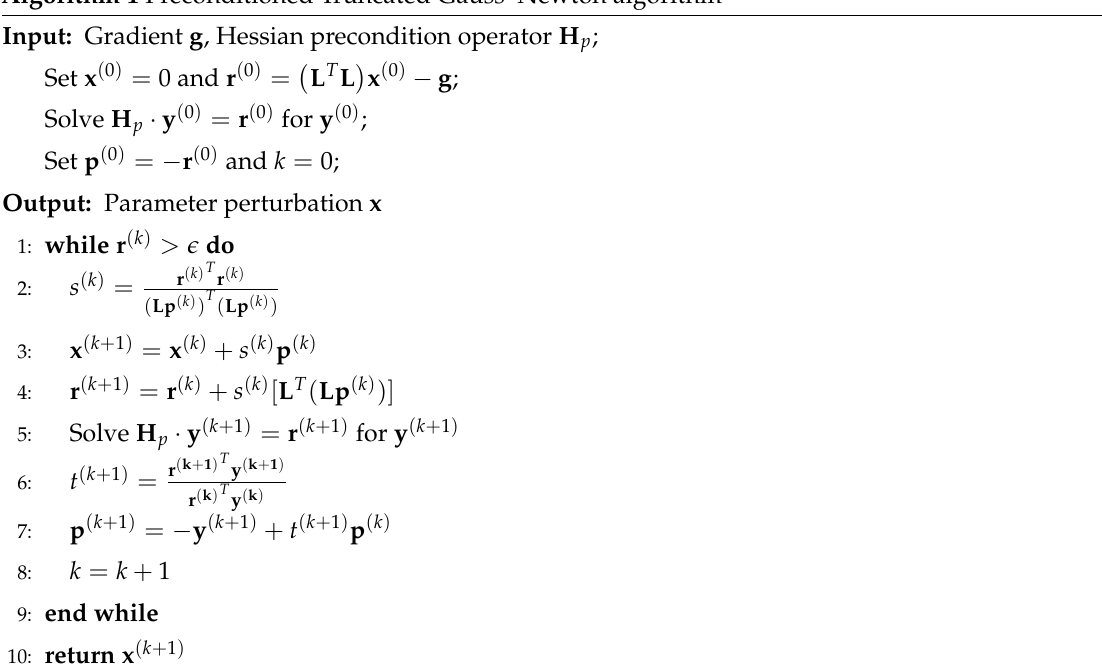
Algorithm 1 Preconditioned Truncated Gauss–Newton